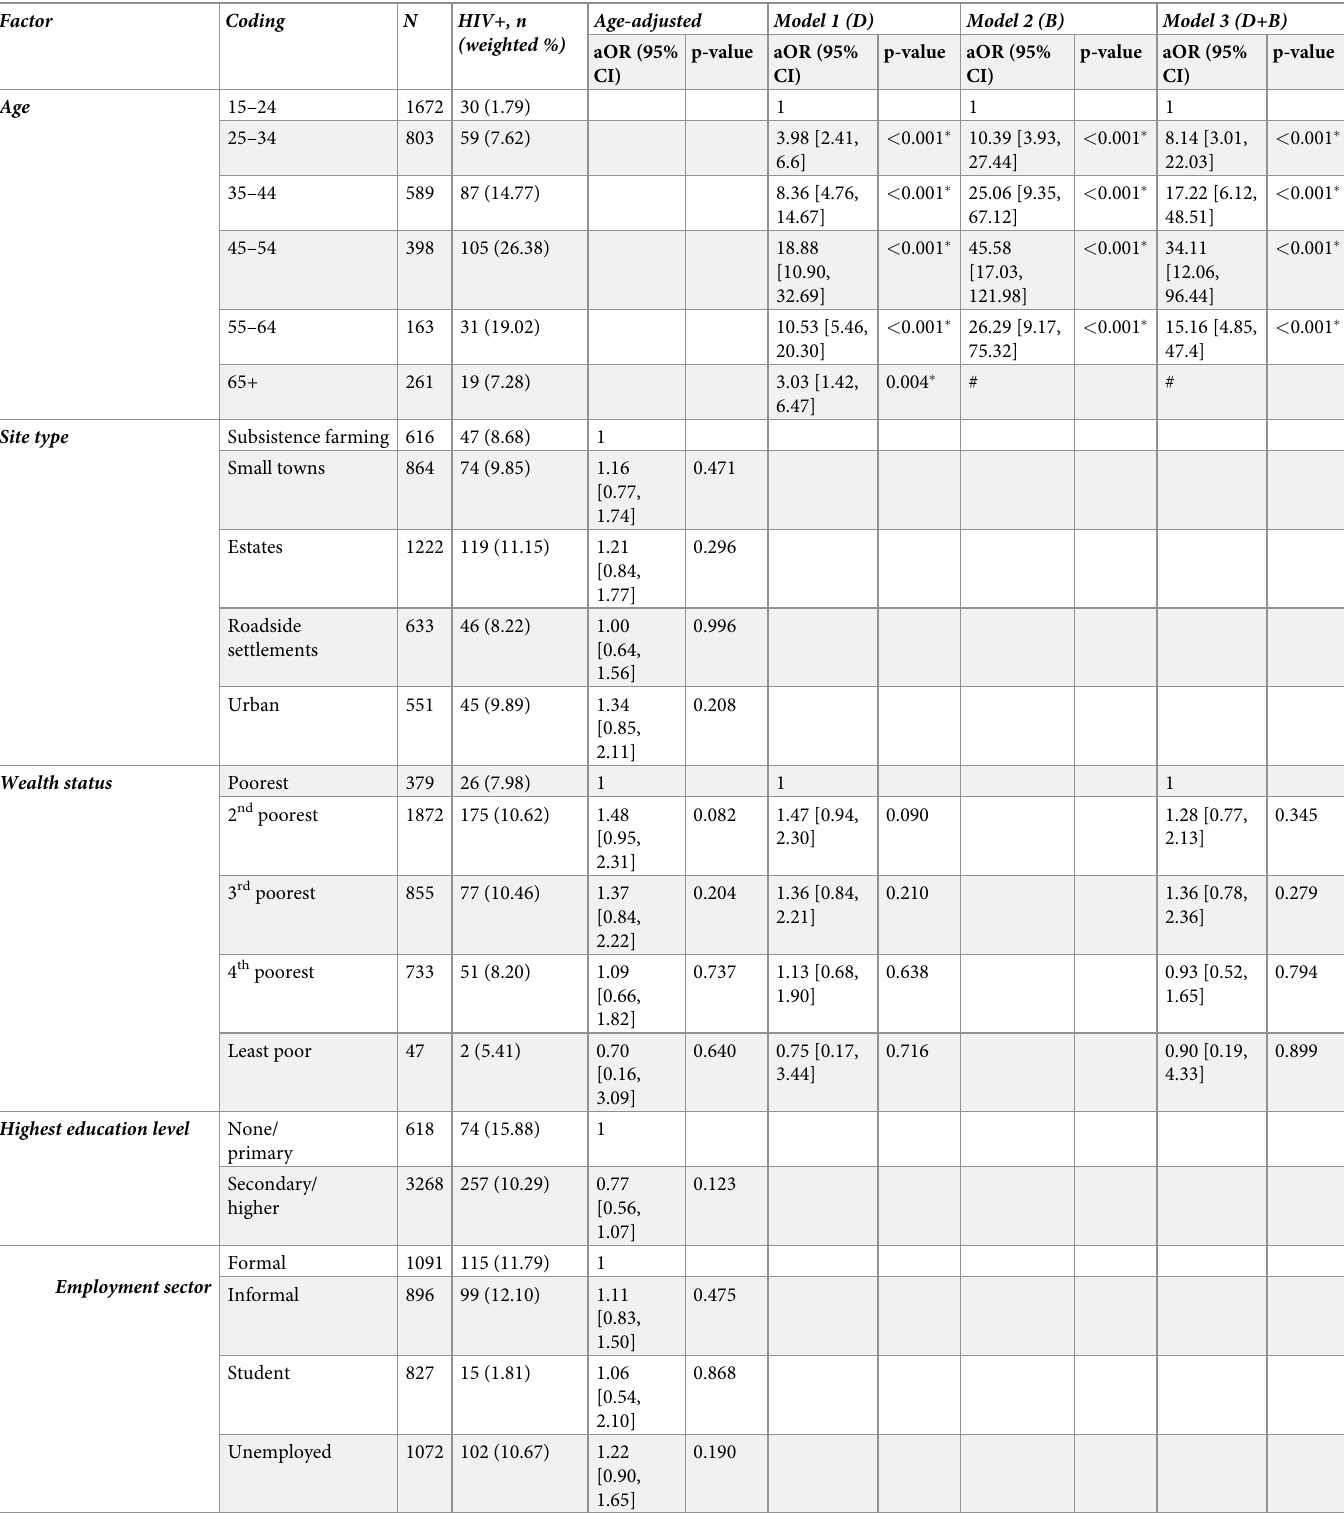
Table 1. Age-adjusted and multivariate models of socio-demographic and behavioural risk factors associated with HIV prevalence in males (N =